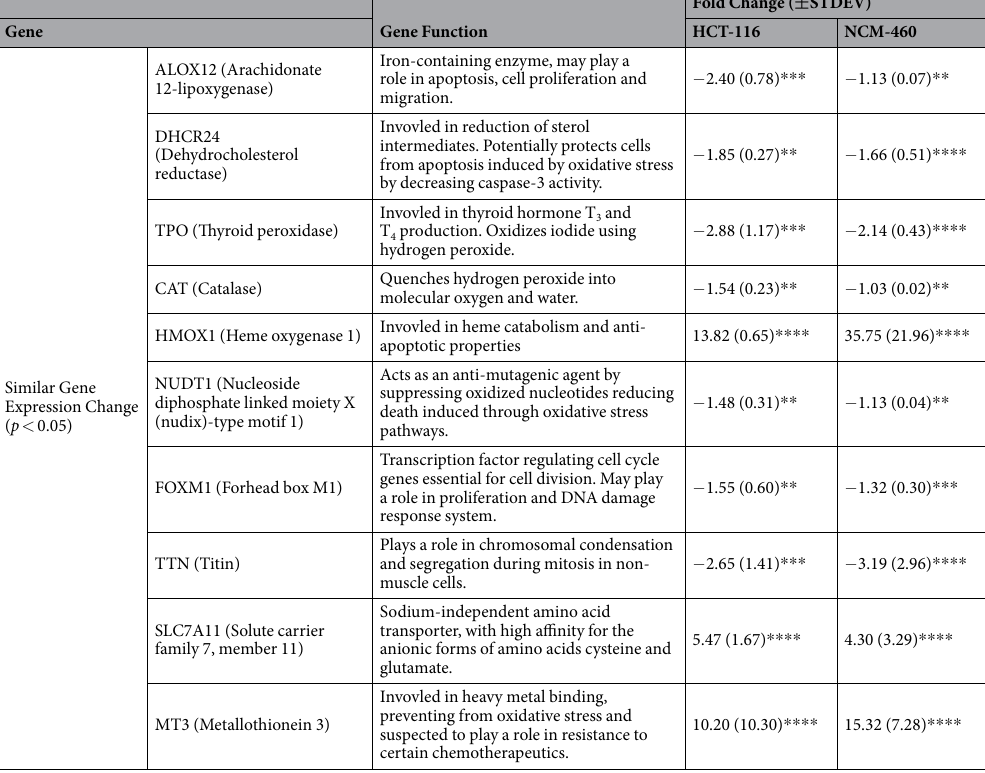
Table 3. Summary of the Relative-Fold Change in Gene Expression Utilizing RT 2 PCR. Statistical analysis was performed using One-Way ANOVA to relative-fold change of the control (1). * p < 0.05 vs control; ** p < 0.01 vs control; *** p < 0.001 vs control; **** p < 0.0001 vs control. n.s. = not significant, p > 0.05 vs control. N/A = not applicable due to no amplification detected. Gene function was obtained searching the UniProt or NCBI Gene